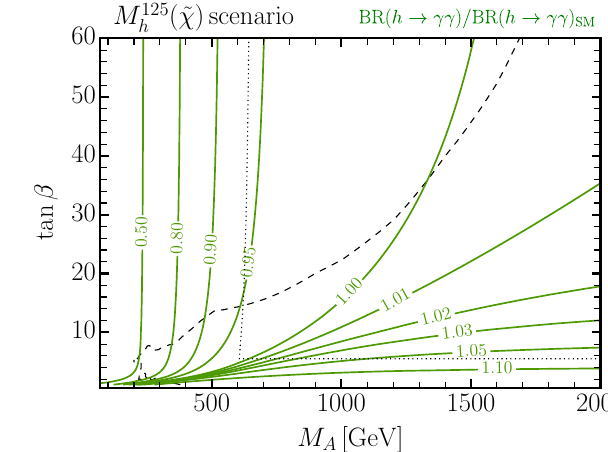
the same as in Fig.1. In the lower-left corner of the plane, the blue region that is excluded by the LHC searches for